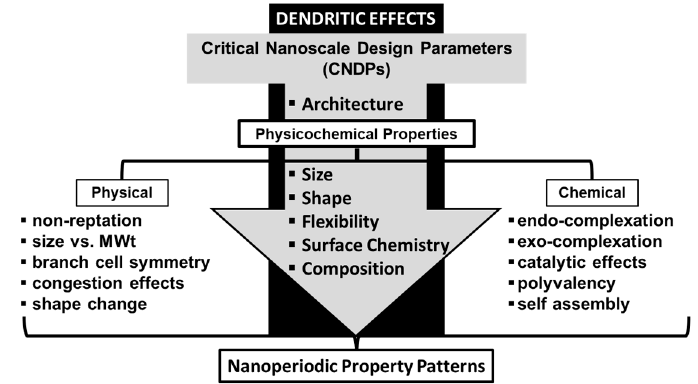
Figure 29. The relationship of dendritic effects to critical nanoscale design parameters (CNDPs) that include: (1) size, (2) shape, (3) surface chemistry, (4) flexibility/rigidity, (5) architecture and (6) elemental composition and the emergence of nanoperiodic property patterns based on these relationships. Reproduced by permission of [27] The Royal Society of Chemistry (RSC) on behalf of the Centre National de la Recherche Scientifique (CNRS) and the RSC.